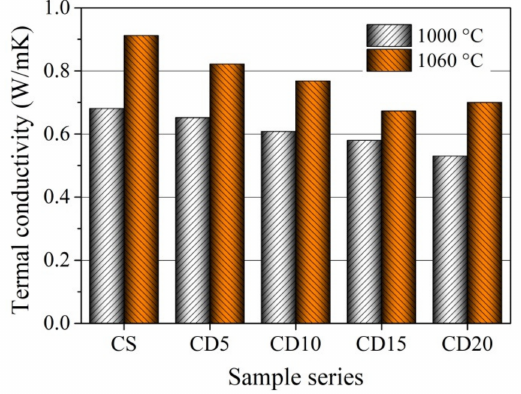
Figure 14. Thermal conductivity of ceramic bodies fired at 1000 and 1060 ◦